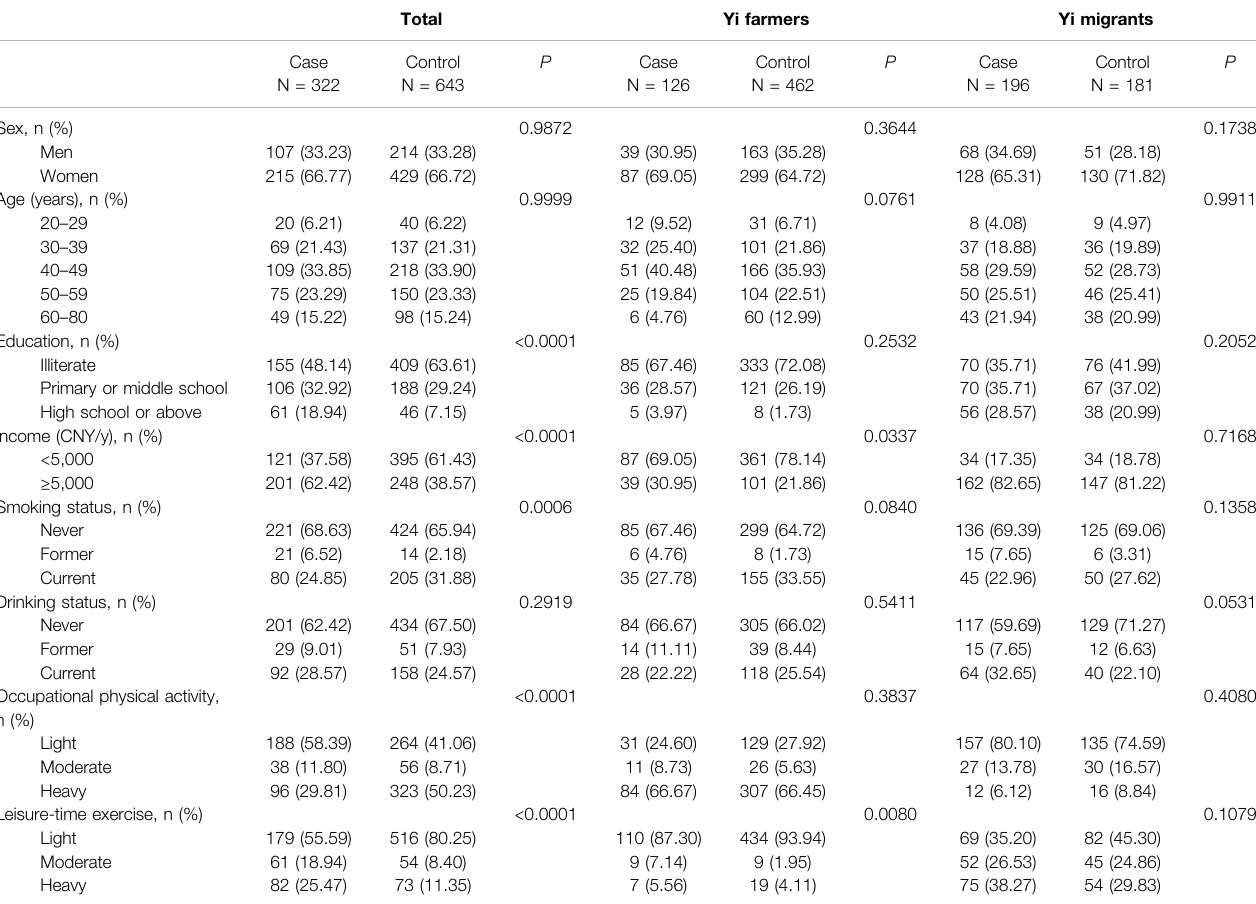
TABLE 1 | Basic characteristics of the case and control groups in Yi